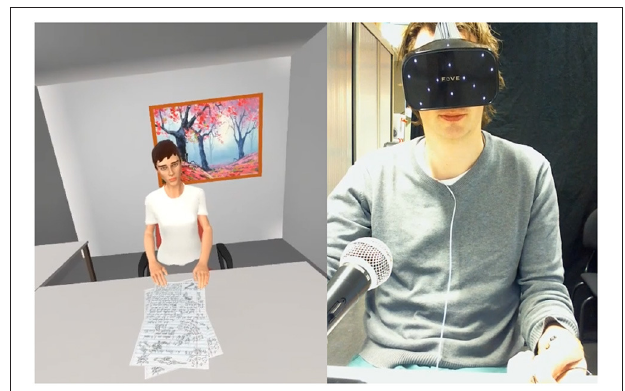
FIGURE 1 | Experiment setup with the agent (left) and the participant